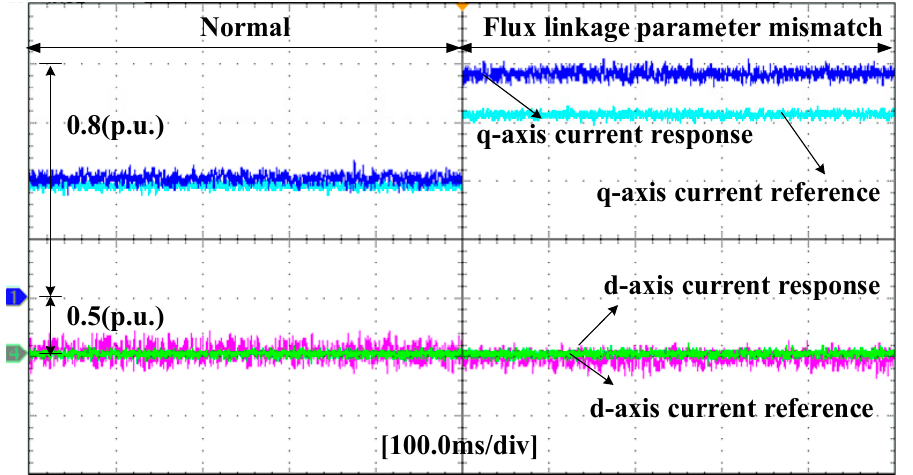
Figure 13. Experimental results of the conventional PCC method under flux linkage parameter perturbation.